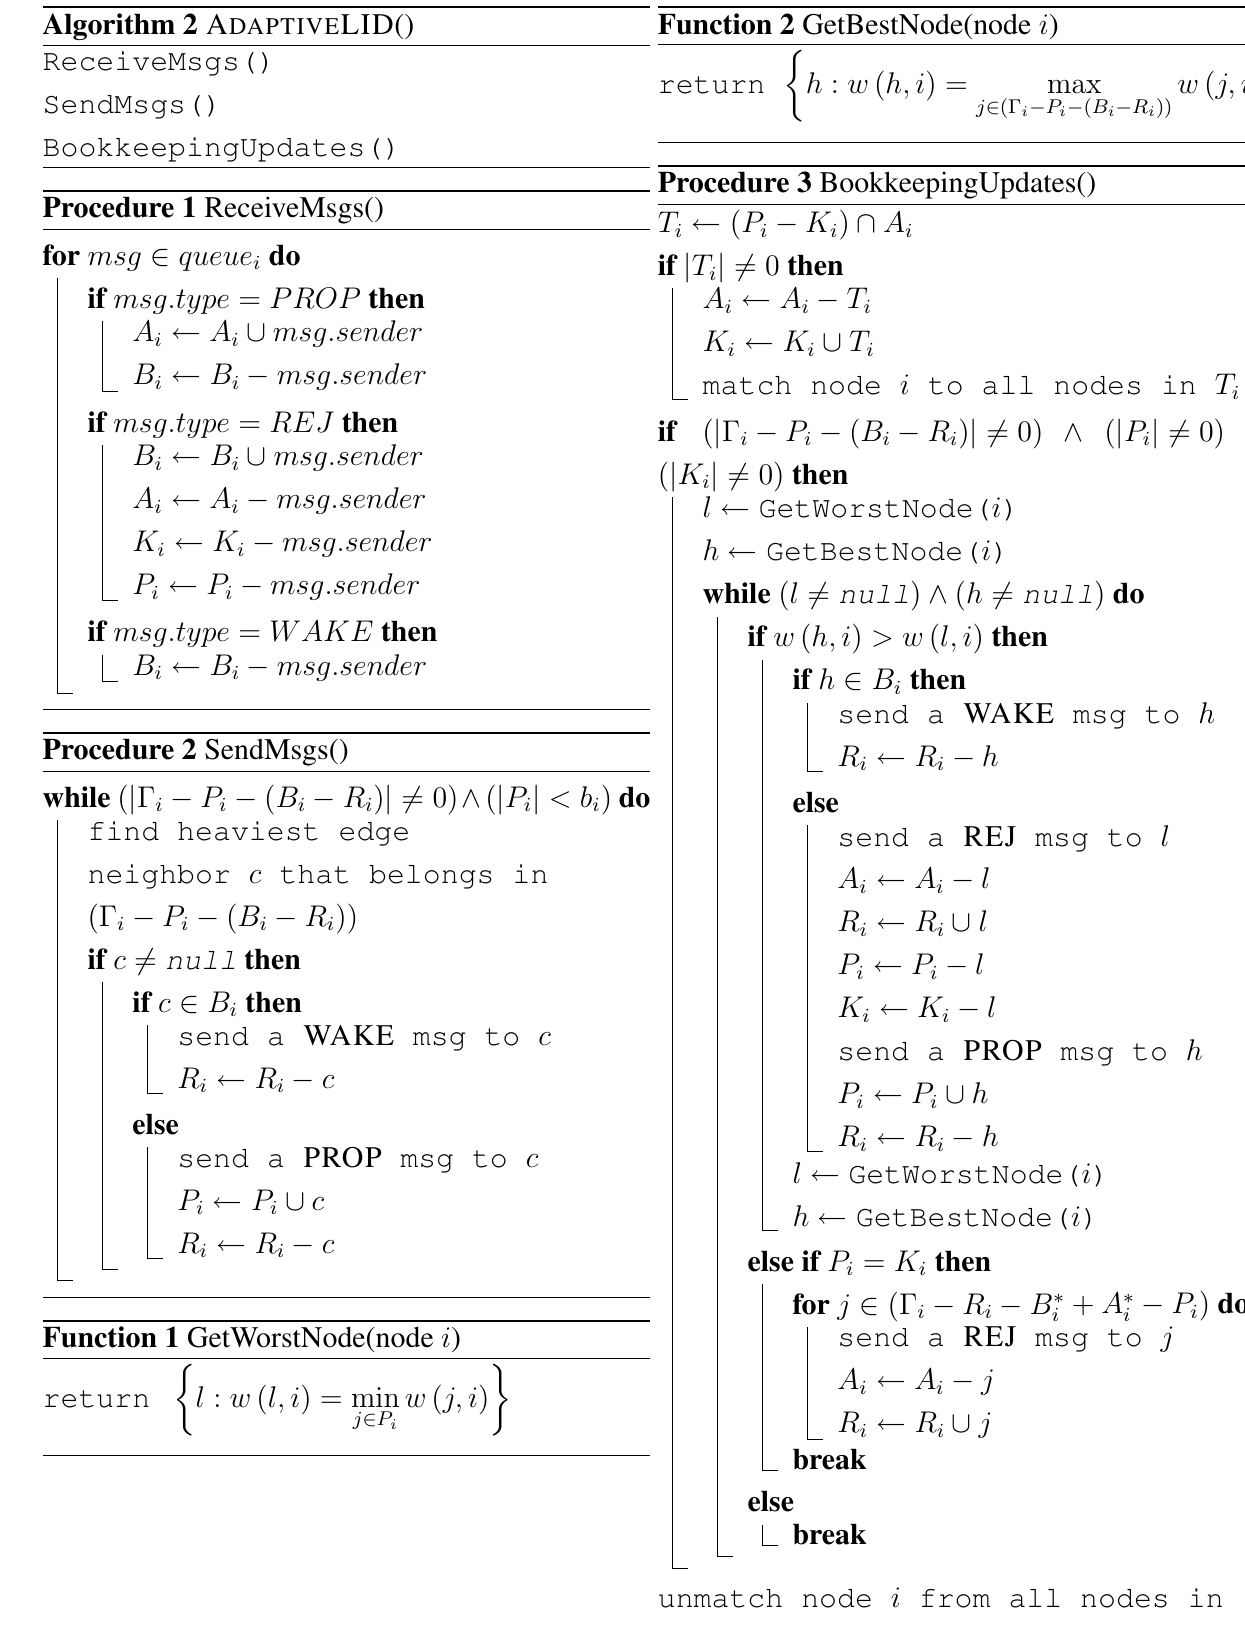
Algorithm 2 A DAPTIVE